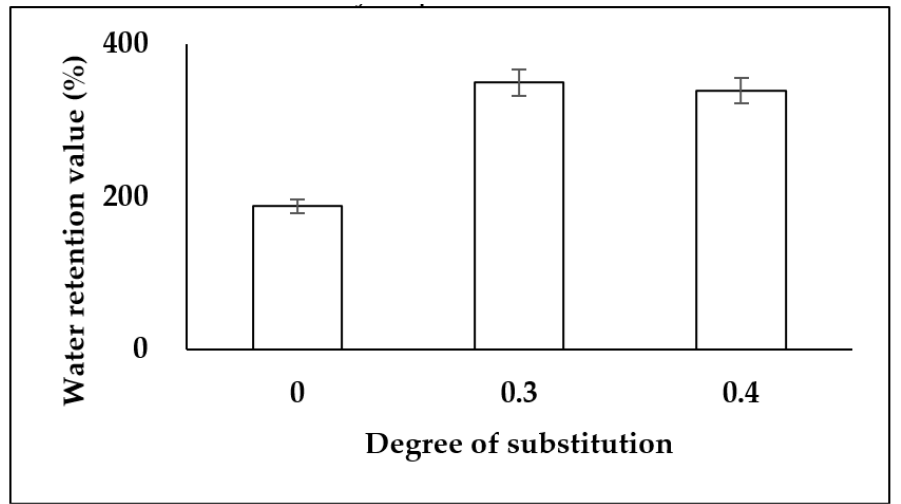
Figure 3. Different water retention values from different DS − treated green waste biomass.